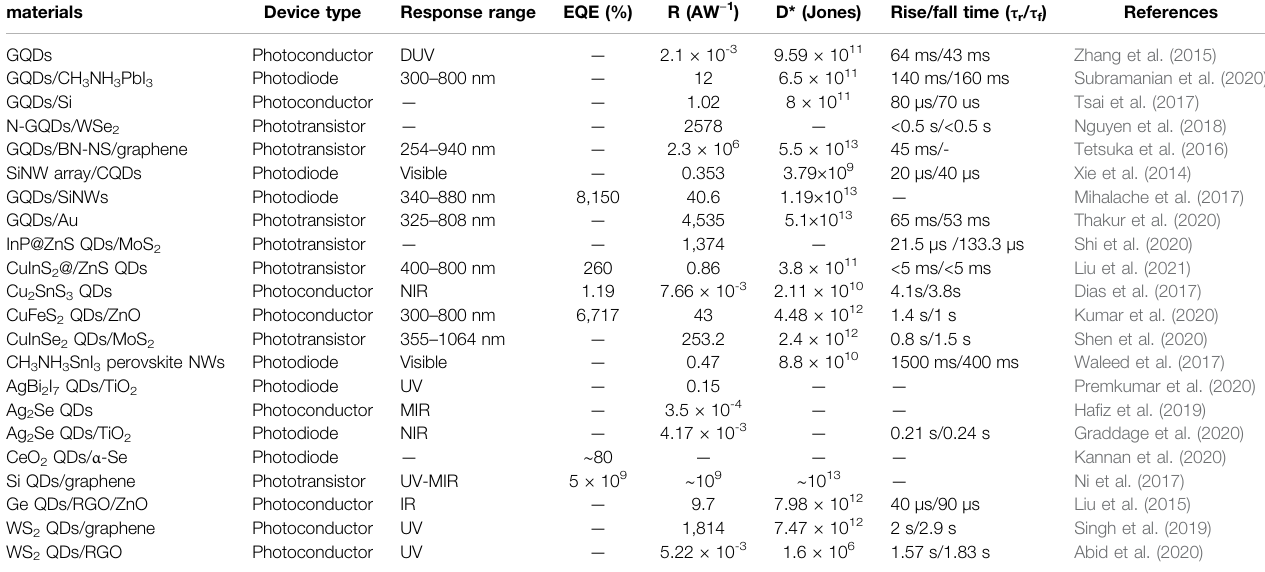
TABLE 1 | Summary of the PDs in Figures 3 – 10